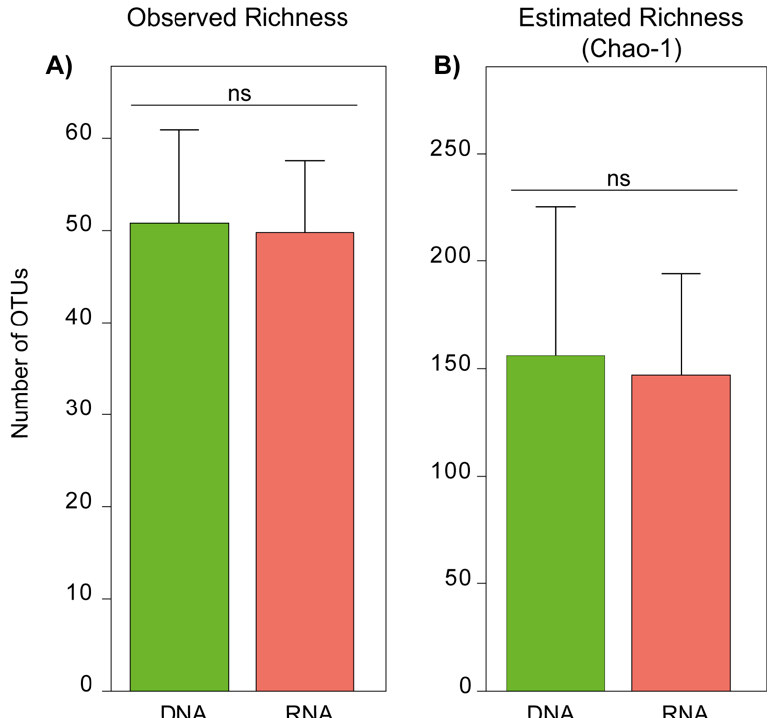
Figure 1. Observed richness and estimated richness for aquatic fungi in the DNA- and RNA-derived communities in subsurface aquatic habitat. ( A ) mean operational taxonomic unit (OTU) richness (number of OTUs detected) and ( B ) mean estimated richness (Chao-1) (mean + standard error (S.E.), n = 20). Significance in differences between mean values of observed richness and estimated richness (Chao-1) is based on paired t-test ( p > 0.05).